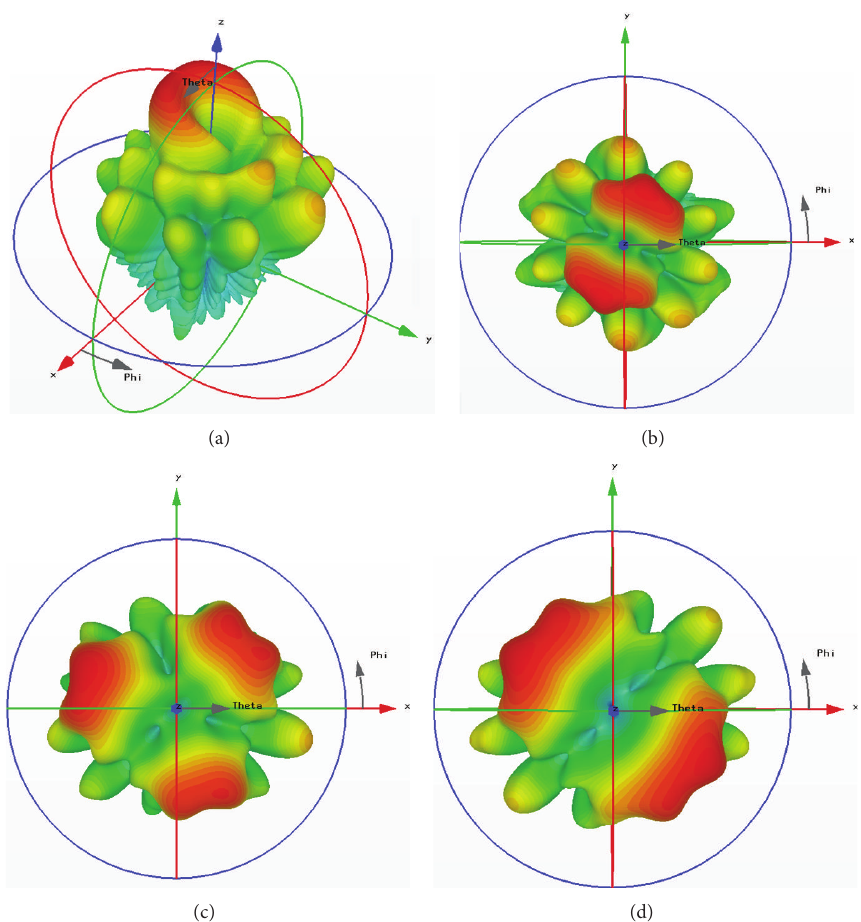
= 2 , ℓ = 1 ; (b) ℓ out in